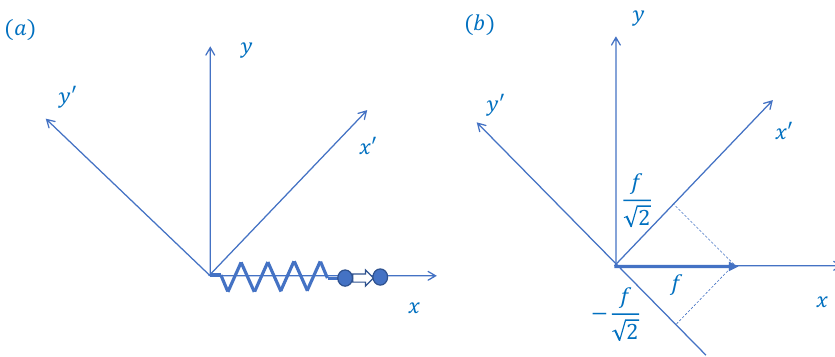
Figure A1. Conceptual illustration of symmetry in law ( a ) spring is stretched along x axis and ( b ) in xy coordinate system force vector’s y component is zero. in x (cid:48) y (cid:48) coordinate system neither component of force vector is zero.